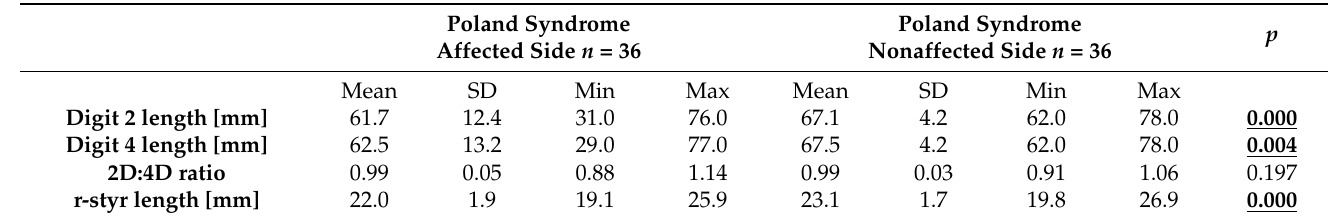
Table 1. Comparison of hand parameters between affected and nonaffected sides in patients with Poland syndrome.